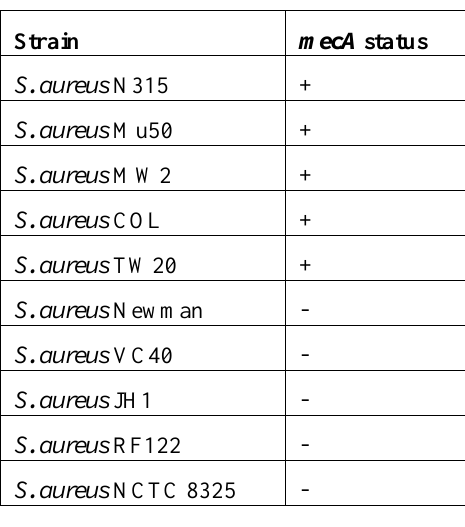
Tab. 1: Bacterial strains used in the